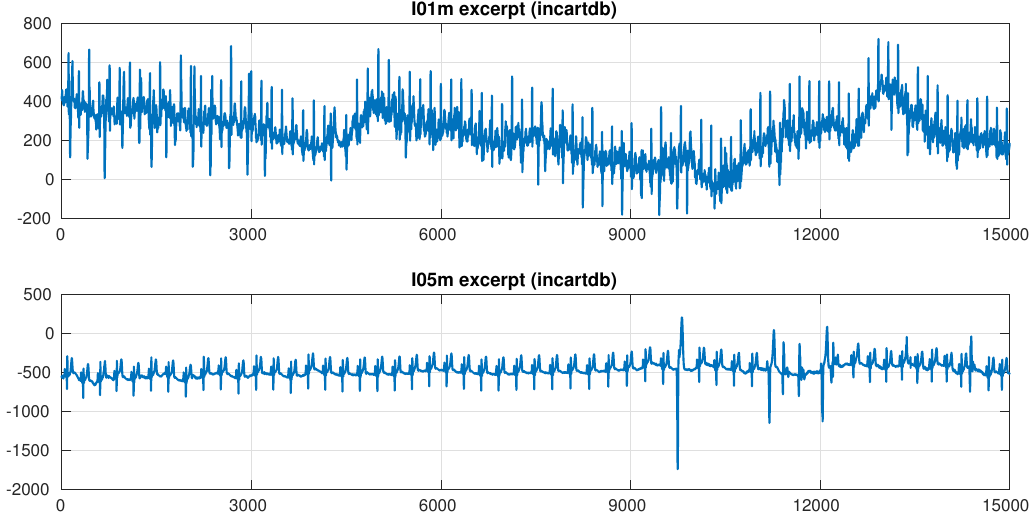
Figure 5. Excerpts of a very noisy I01m ( top ) and a rather clean I05m ( bottom ) INCART